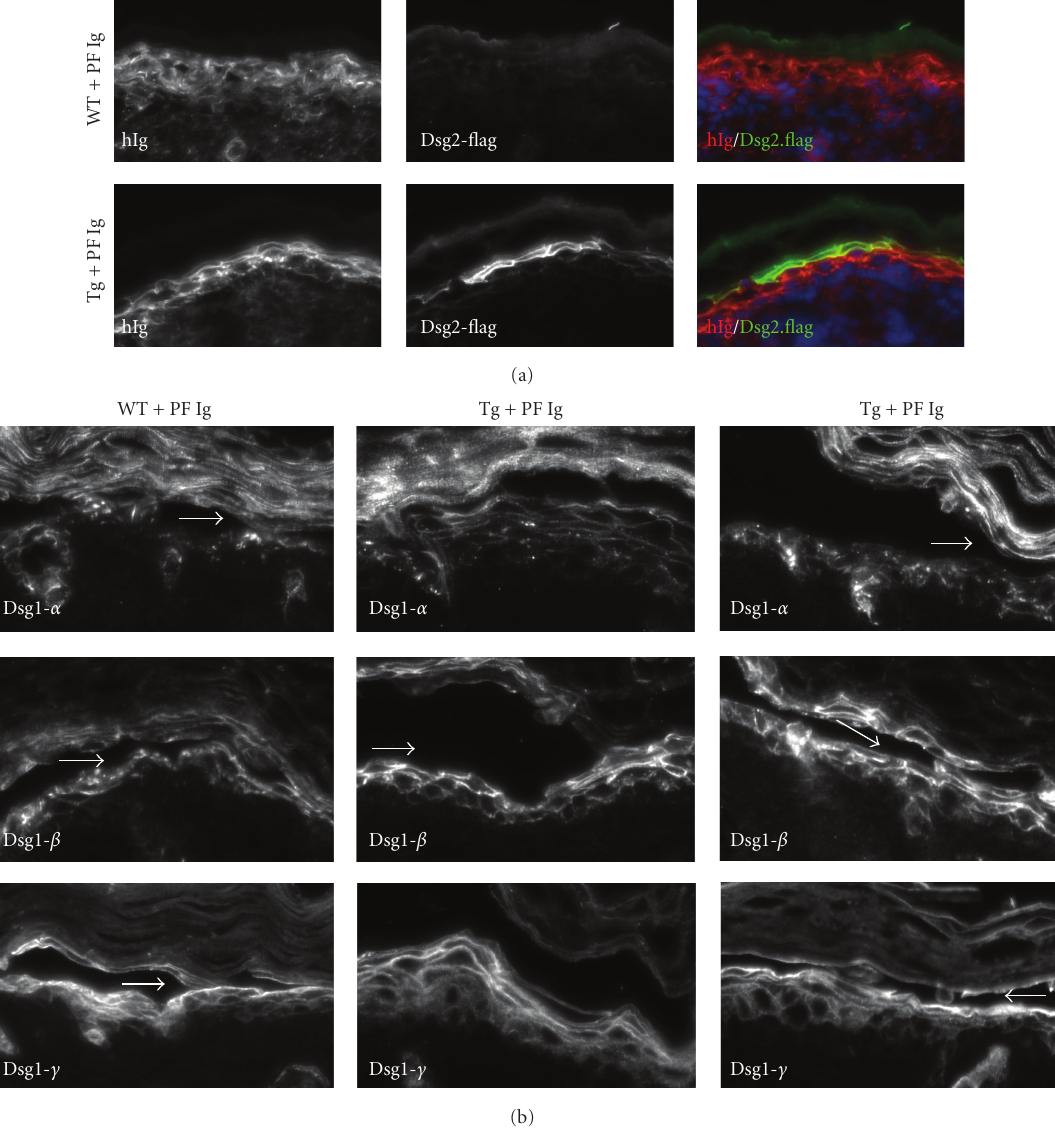
Figure 5: Superficial expression of Dsg2 reduces disruption of Dsg1 in response to PF Ig. Newborn WT and Dsg2 Tg mice were injected subcutaneously with PF Ig, and, 18 hours later, back skin samples were frozen in OCT or were fixed in formalin and embedded in para ffi n for immunostaining. (a) Direct immunostaining for human Ig (hIg, left panels), showing localization of human antibodies to the epidermis after PF Ig passive transfer. The same tissue was immunostained with Flag antibodies, demonstrating the presence of Dsg2-Flag in the Tg, but not WT, skin (middle panels). Double labeling for the human Ig (red) and the Flag tag (green) is shown (right panels). Staining of human Ig was considerably more intact at the cell-cell border in the Tg skin, particularly in the superficial epidermis, where Dsg2 was expressed. Thus, superficial Dsg2 retains PF Ig at the cell-cell borders. (b) Lesional and nonlesional back skin sections were then immunostained with antibodies AP61, AP498, and Ab15, which were raised against the extracellular domain of Dsg1- α , Dsg1- β , and Dsg1- γ , respectively. DAPI (blue) was used as a nuclear stain. Arrows demarcate site of blister cleavage (lesional skin). In WT mice, treatment with PF Ig dramatically disrupted cell-cell border staining of Dsg1- α and Dsg1- β but not Dsg1- γ (left panels). Superficial expression of Dsg2 reduced the extent of Dsg1 perturbation (internalization and degradation). There was no significantly observable di ff erence between lesional and non-lesional